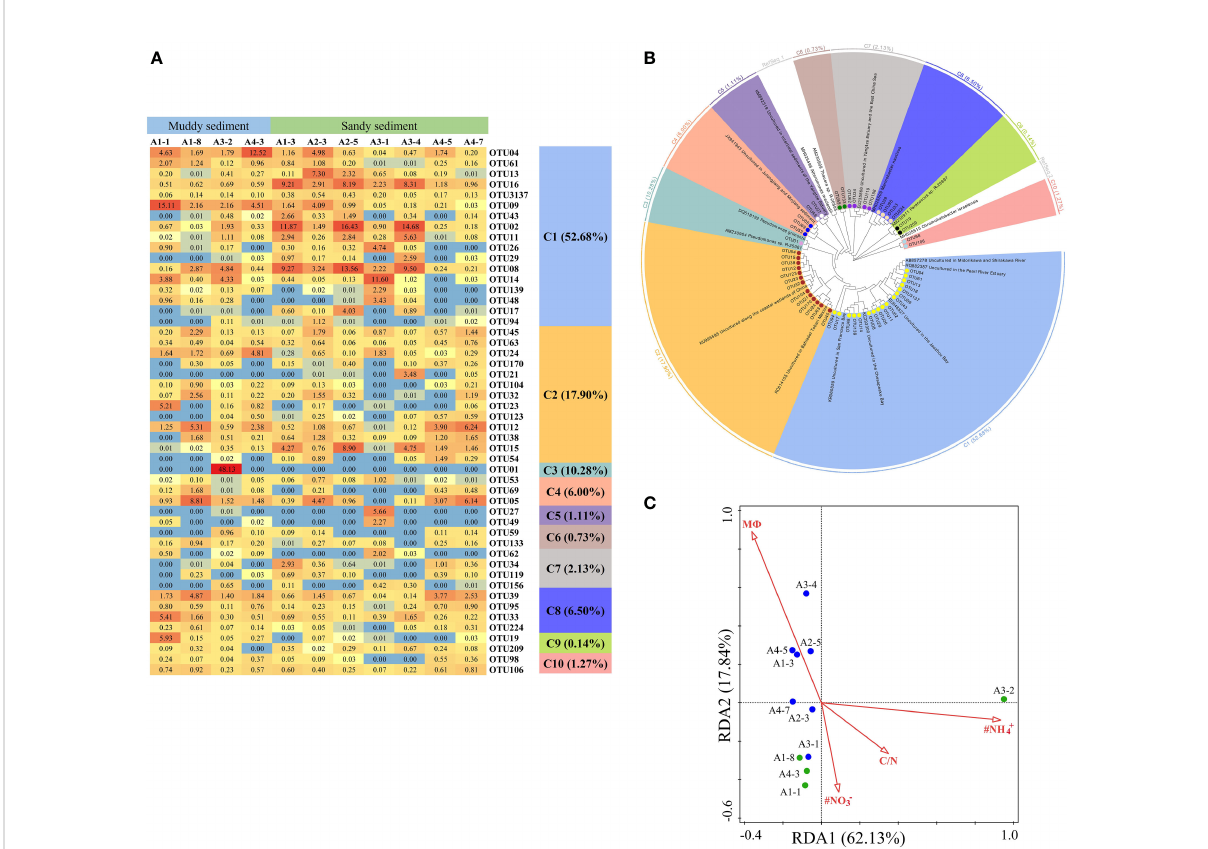
FIGURE 6 (A) The heat map of the dominant denitri fi cation OTUs for the nir S gene (top 50 OTUs, 97% cutoff). (B) Reconstructed phylogenetic tree with neighbor-joining method of partial nir S-gene sequences (bootstrap 1000). (C) The redundancy analysis (RDA) for environmental factors and the nir S gene-encoded denitrifying